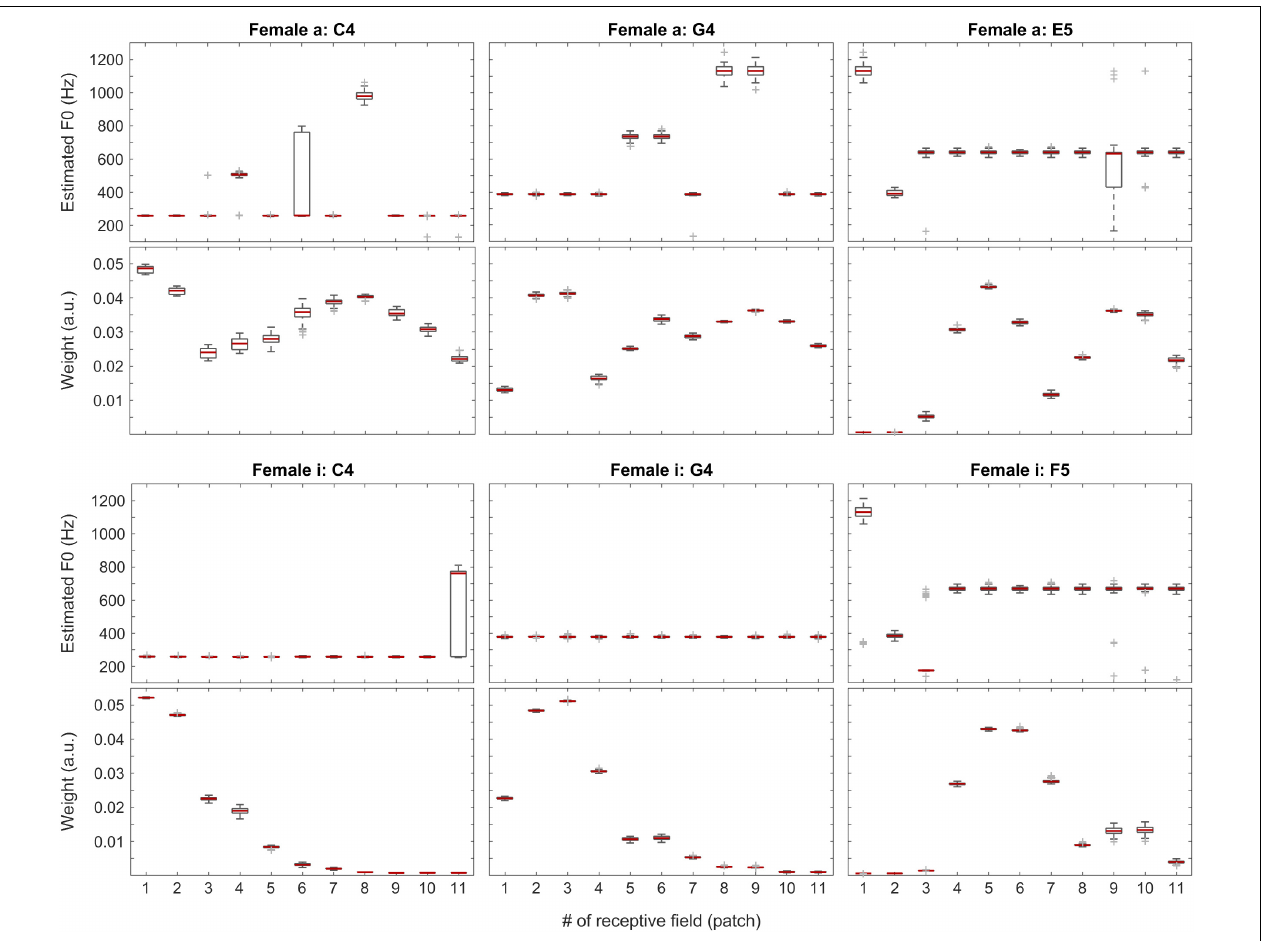
FIGURE 6 | F0 estimates (first and third rows) and weights (second and fourth rows) for all patches over all 100 iterations for the vowels a: (top two rows) and i: (bottom two rows) sung by a female